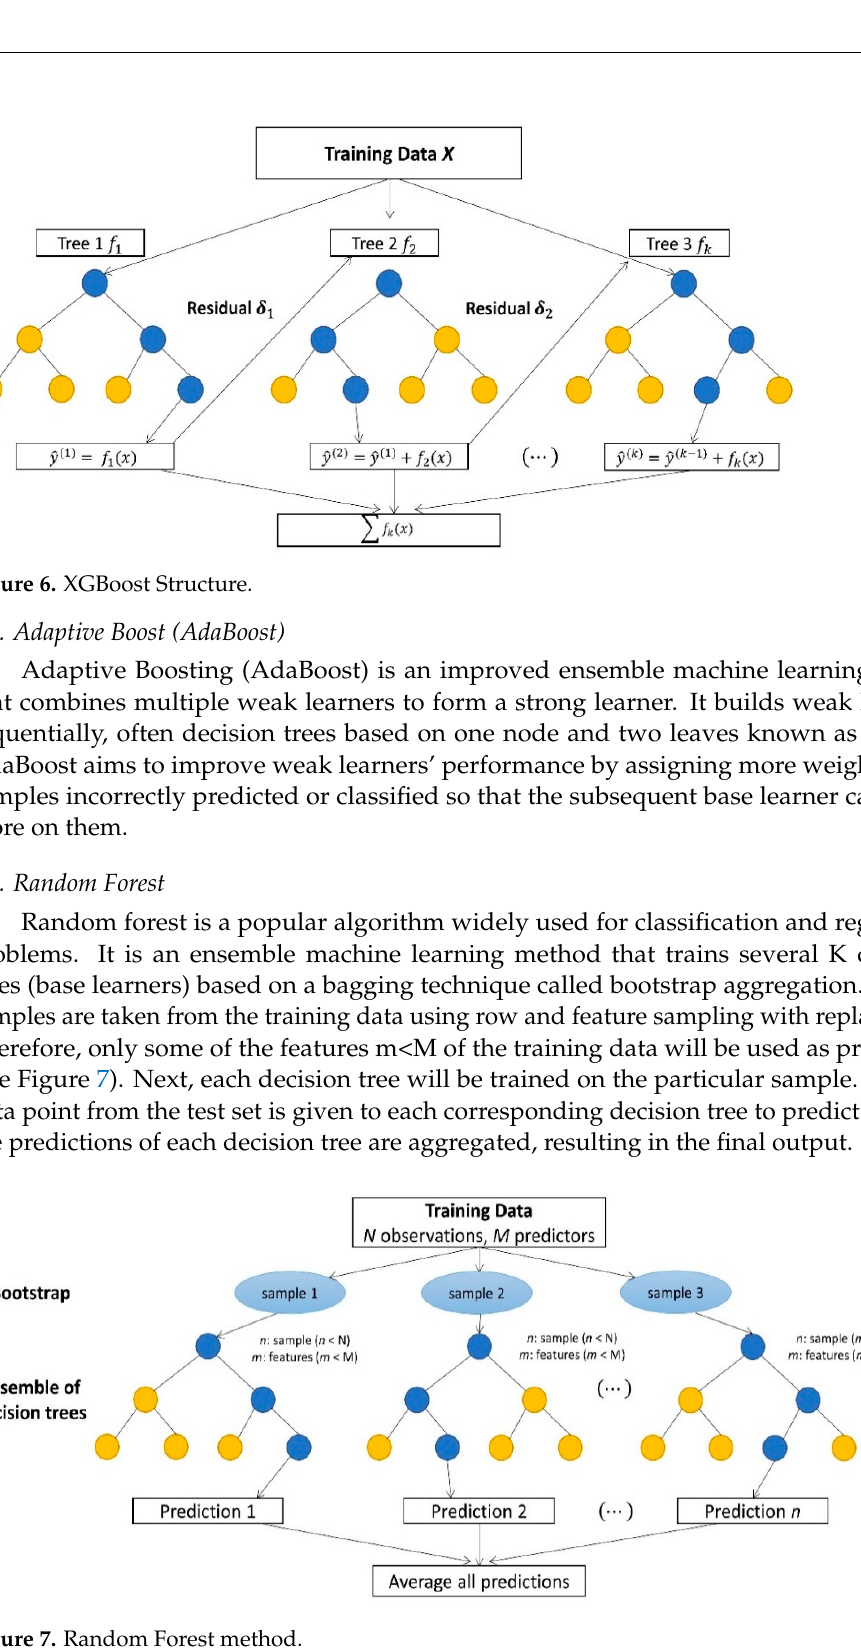
Figure 7. Random Forest method.